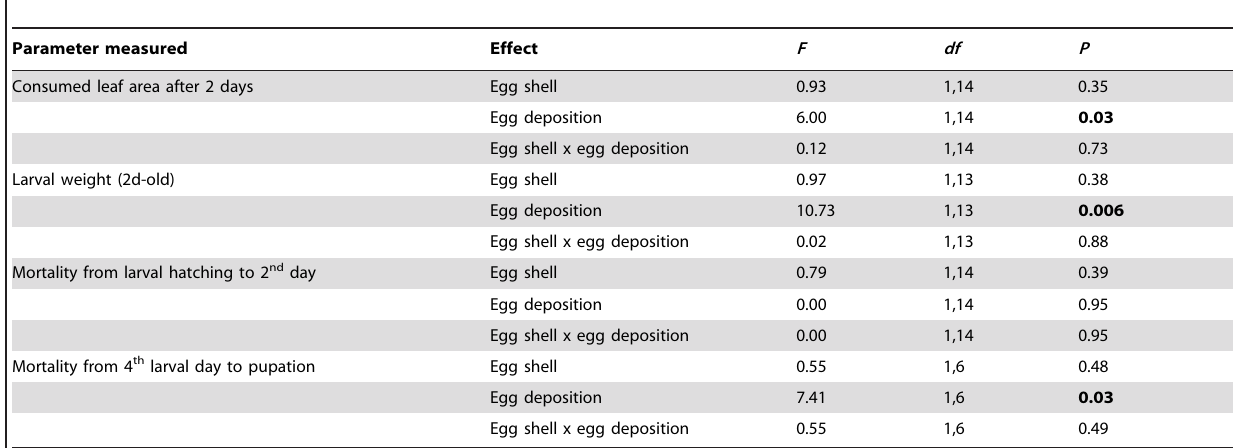
Table 2. ANOVA statistics for effects of prior egg deposition and consumption of egg shells on the larval performance of Pieris brassicae on Arabidopsis thaliana Col-0 plants (experimental data in Table